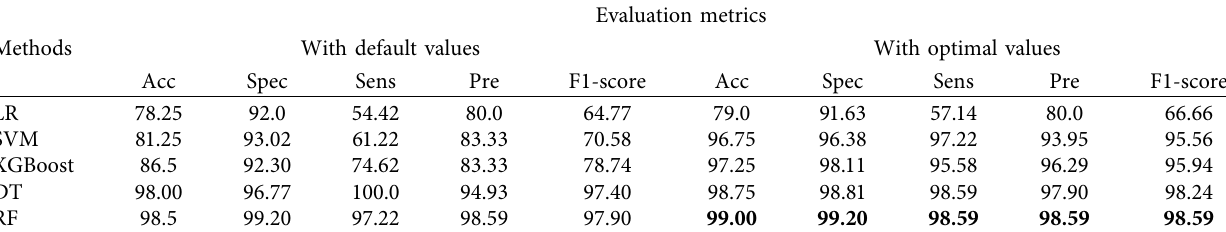
Table 3: The obtained performance with and without hyperparameters